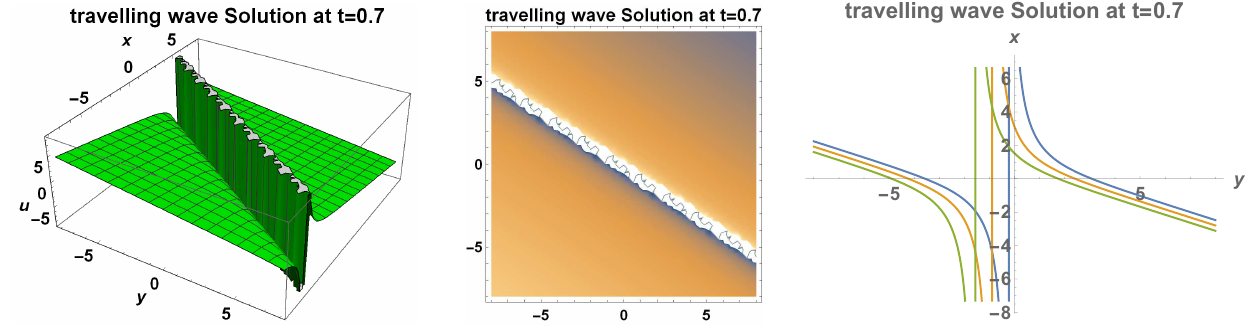
Figure 22. Wave profile depiction of nontrivial bounded solution (101) at t = 0.4.